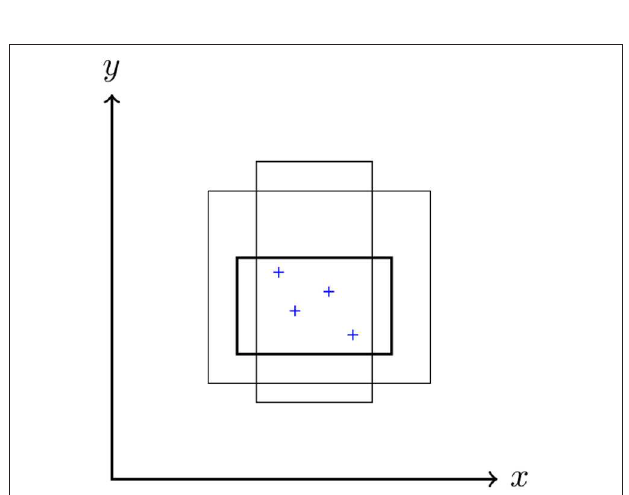
FIGURE 2 | Three different hypotheses represented as axis-parallel rectangles in R 2 , and four positive examples “+” that are all consistent with the three hypotheses. The set of all the rectangles that can be drawn in the plane constitutes the hypothesis space H .